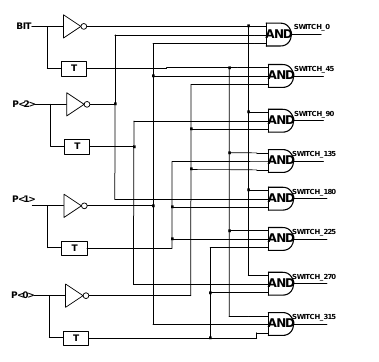
Figure 19. Logic design of